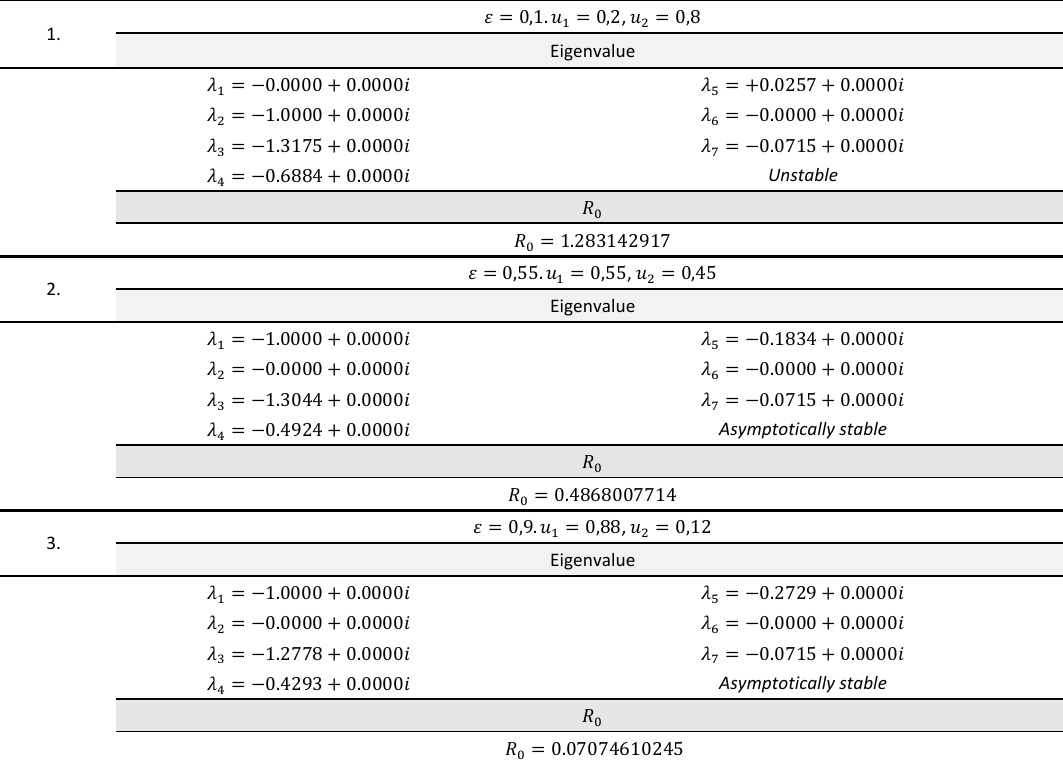
R for the disease-free equilibrium point 0